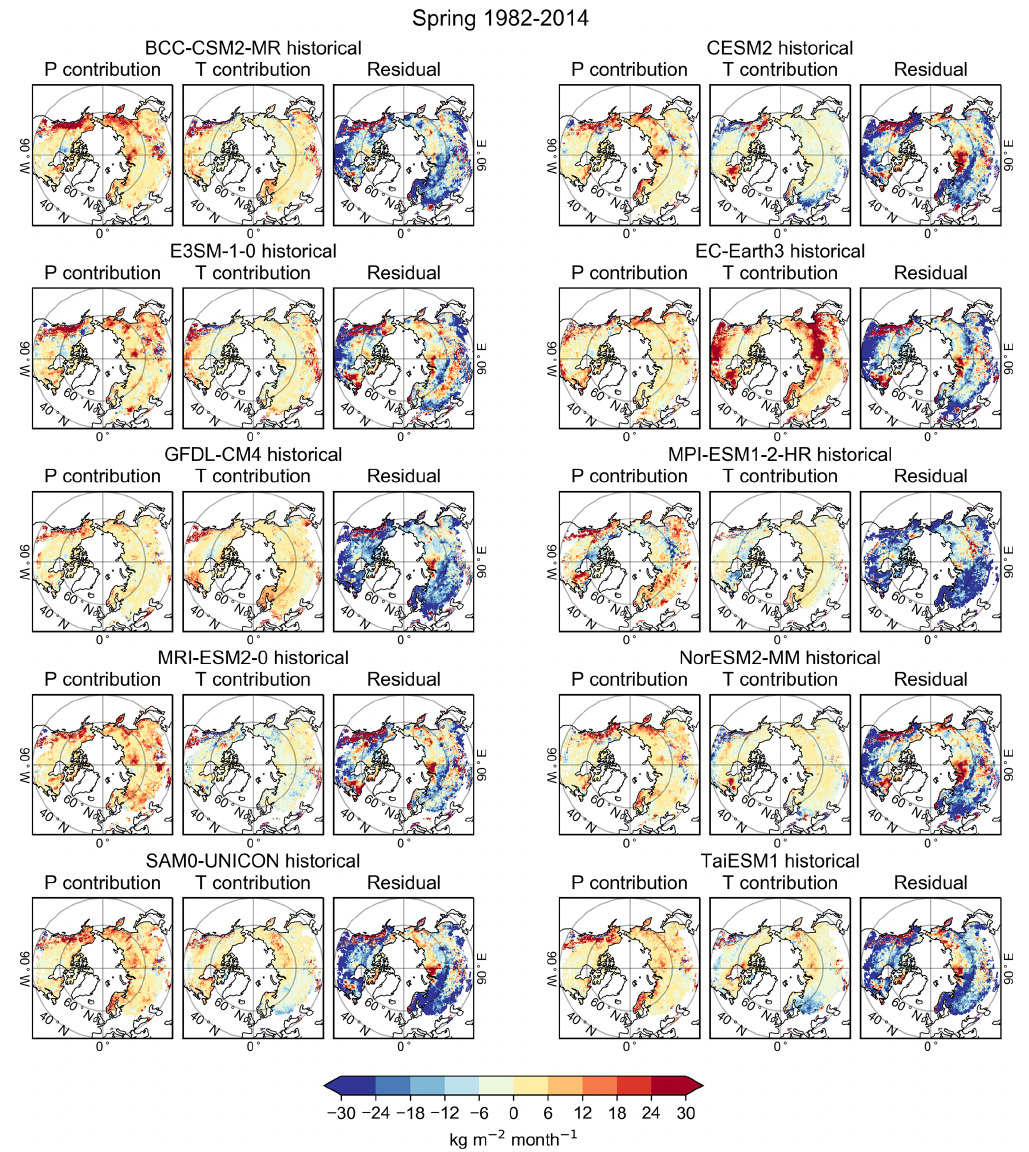
Figure 12. Spatial distribution of the P contribution, the T contribution, and the residual for each model in spring 1982–2014.